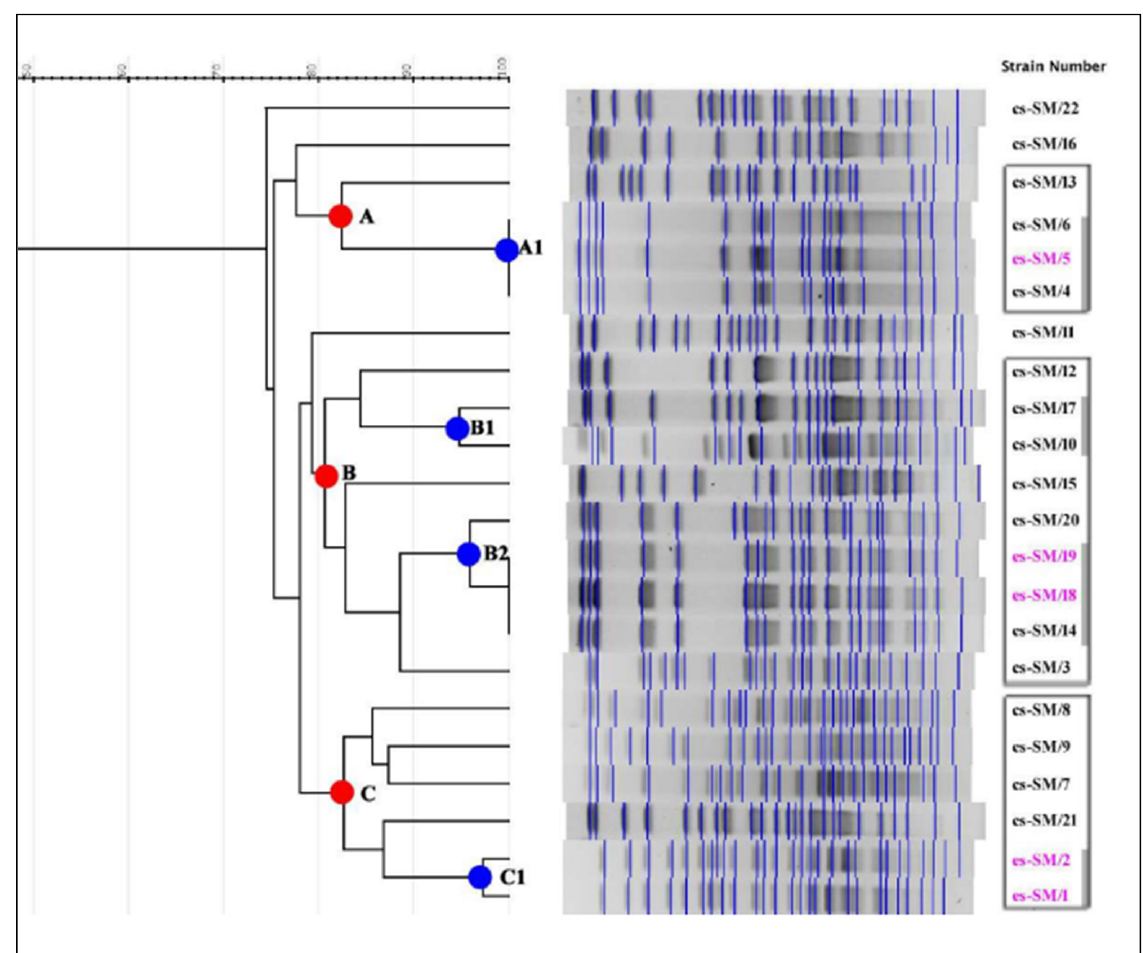
eter; es-SM: environmental sample- Serratia marcescens ; /No.: Identification No. of Serratia marcesens strains; PFGE, pulsed-field gel electrophoresis.